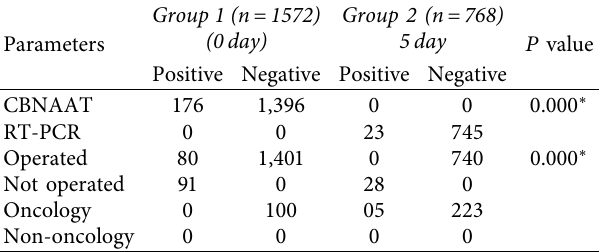
Table 7: Comparison of various parameters between the two study